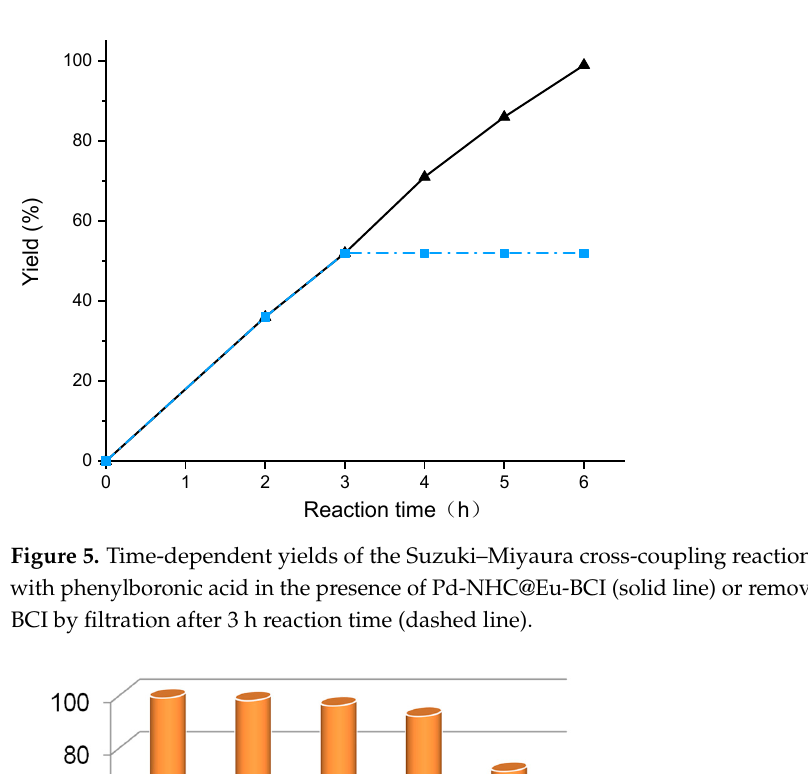
Figure 5. Time-dependent yields of the Suzuki–Miyaura cross-coupling reaction of bromobenzene with phenylboronic acid in the presence of Pd-NHC@Eu-BCI (solid line) or removal of Pd- NHC@Eu-BCI by filtration after 3 h reaction time (dashed line).